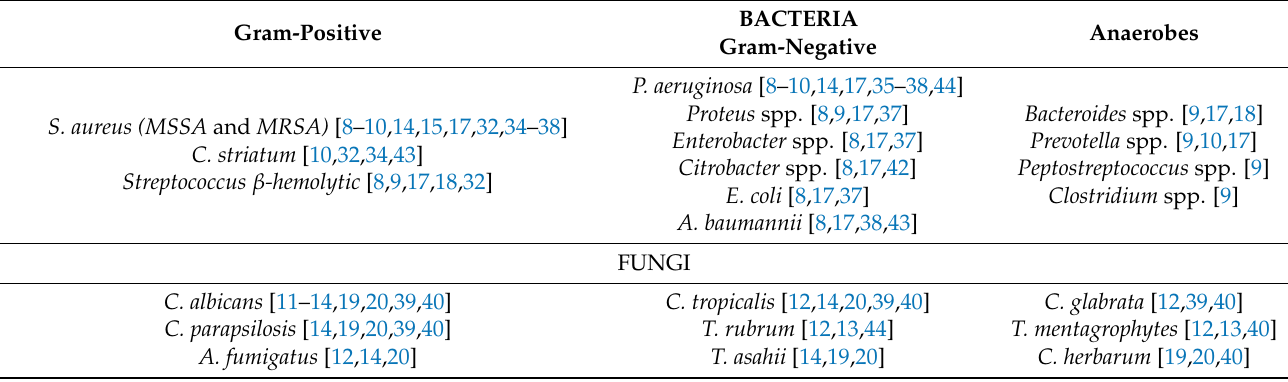
Table 1. Most predominantly identified microorganisms in DFUs, comprising both Gram-positive and Gram-negative bacteria, as well as anaerobic bacteria and fungi. All microorganisms are presented in order of the greatest abundance in